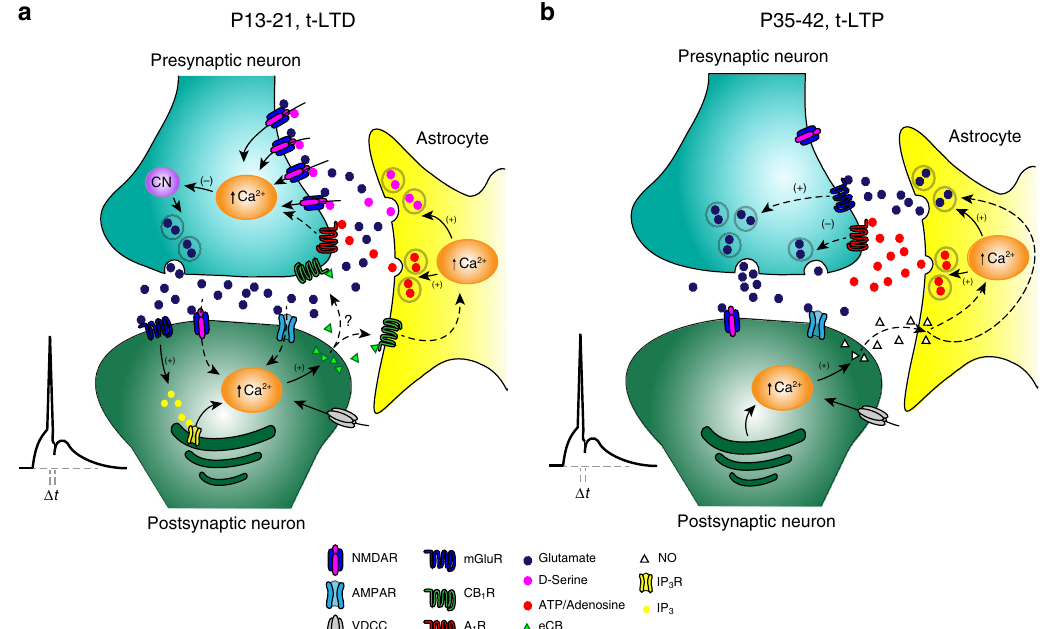
Fig. 7 Model showing the switch from t-LTD to t-LTP occurring with maturation at CA3 – CA1 synapses of the hippocampus. a At P13 – 21, a known presynaptic form of t-LTD is induced by a post-pre single-spike pairing protocol. In this presynaptically expressed form of t-LTD, postsynaptic action potentials activate voltage-dependent Ca 2 + channels (VDCCs) and the presynaptically released glutamate activates postsynaptic mGluR, activating PLC and provoking Ca 2 + release from internal stores and DAG production, which serves a precursor for endocannabinoids (eCBs) synthesis. For t-LTD, eCB signal is necessary to activate CB 1 receptors to facilitate D -serine release from astrocytes. Together with the glutamate released from presynaptic neurons, this D -serine is known to activate preNMDAR on Schaffer collateral boutons, leading to an increase in presynaptic Ca 2 + , calcineurin activation and synaptic depression. Modi fi ed from ref. 12,13 . b In the present study, it has been found that at P35-32, t-LTD is not observed and instead the same protocol (a post- pre protocol) induces presynaptic t-LTP. At this developmental stage, the probability of release has considerably decreased owing to an increase in adenosine release from astrocytes compared with P13 – 21. Also different to t-LTD induced by the same protocol at P13 – 21, eCB signaling and NMDAR are not required for presynaptic t-LTP. For the induction of t-LTP, postsynaptic action potentials activates voltage-dependent Ca 2 + channels (VDCCs) causing calcium release from internal stores, inducing NO synthesis. The NO signal leads to the activation of astrocytes to release glutamate and/or adenosine to activate presynaptic mGluR5 and A 1 R respectively on Schaffer collateral boutons. A 1 R activation considerably reduces neurotransmitter probability release whereas mGluR5 activation leads to a long-lasting increase in glutamate release and synaptic